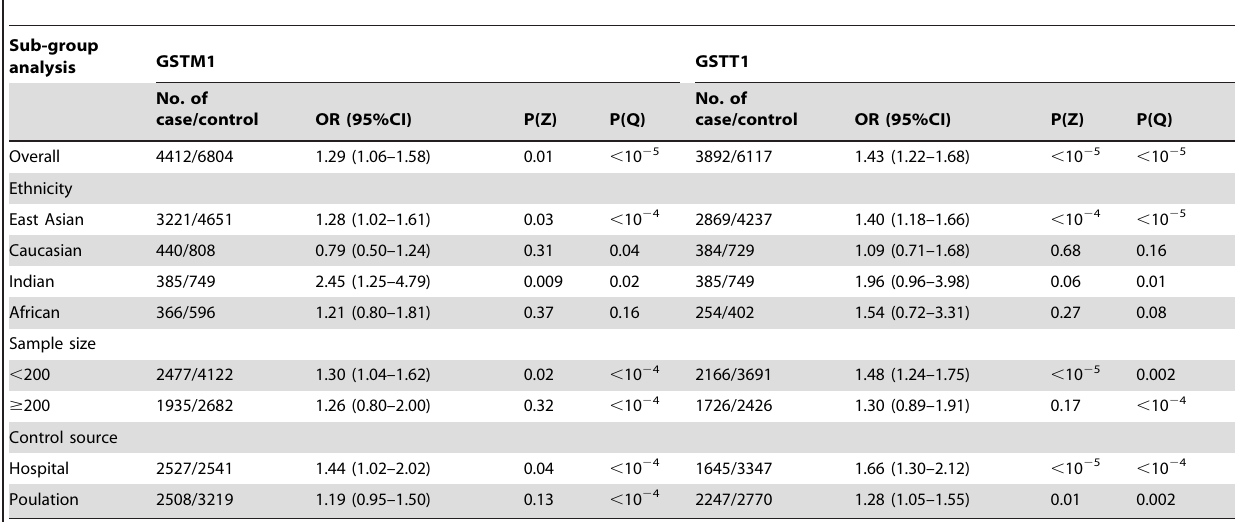
Table 2. Main results of pooled odds ratios (ORs) with confidence interval (CI) in the meta-analysis.